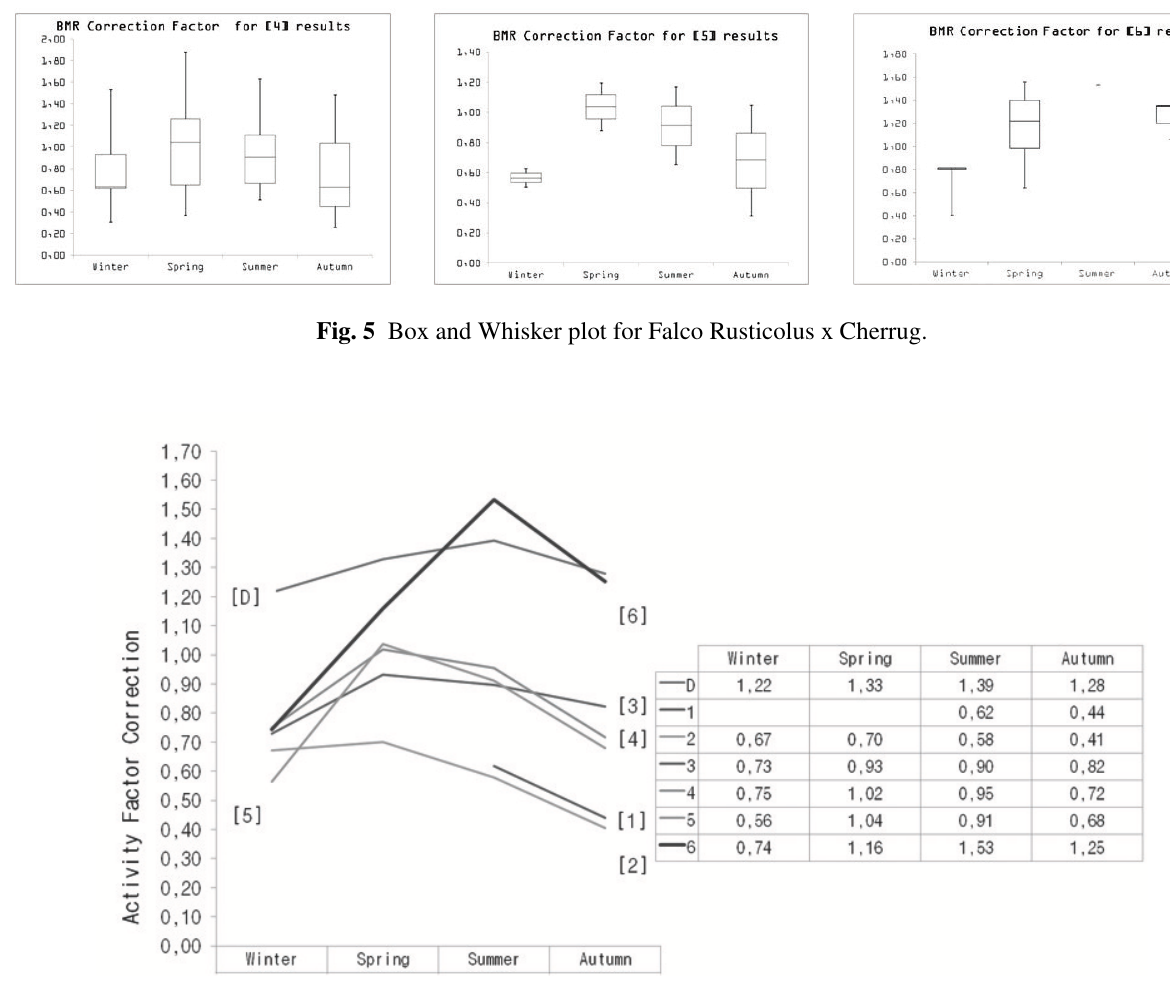
Fig. 6 Example of SMR/BMR Medianan results from Falconges